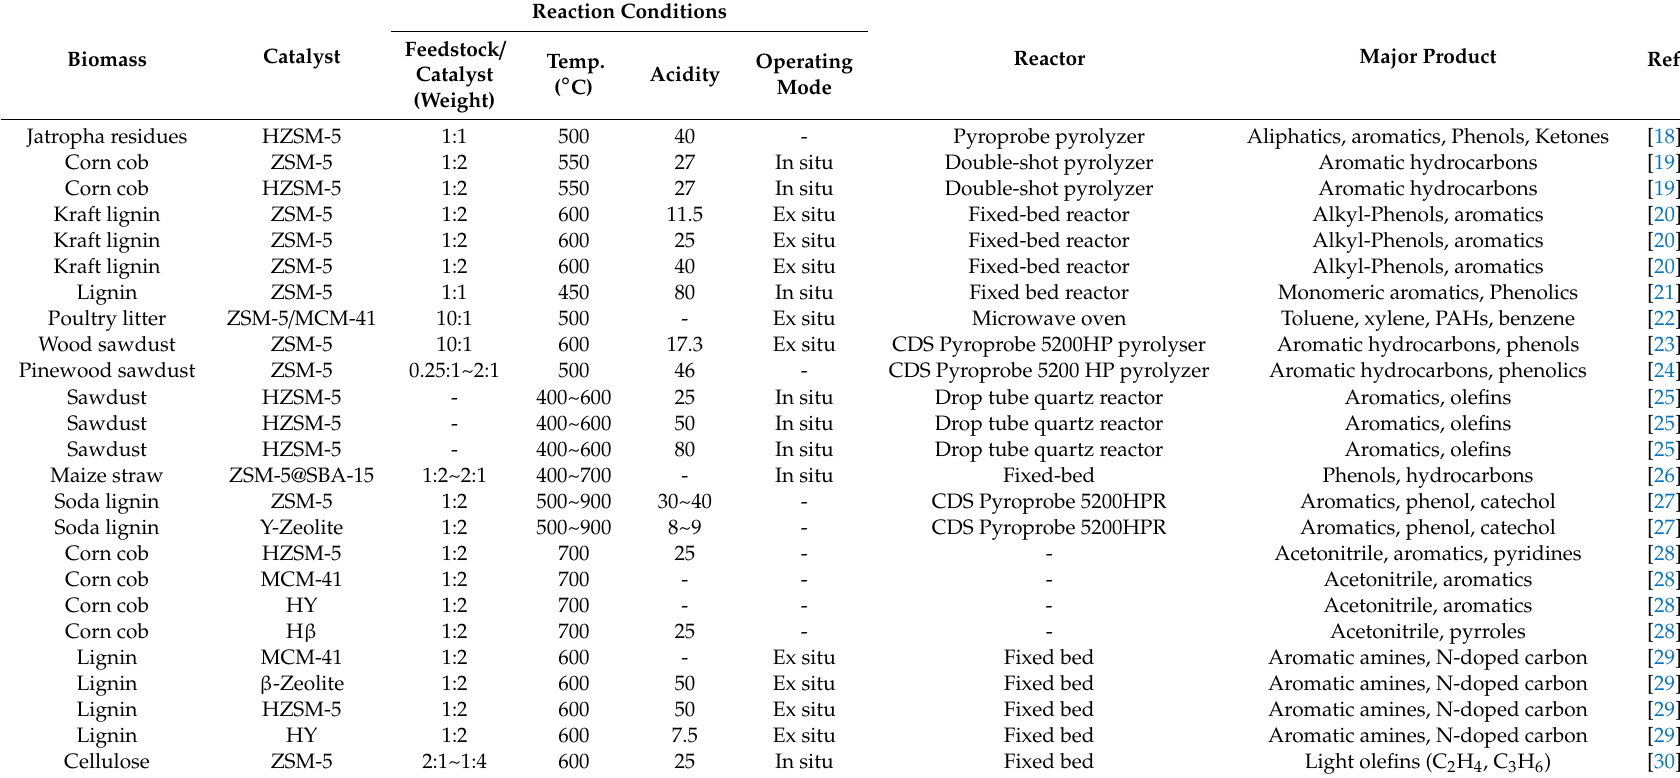
Table 1. Application of traditional zeolite catalyst in catalytic fast pyrolysis